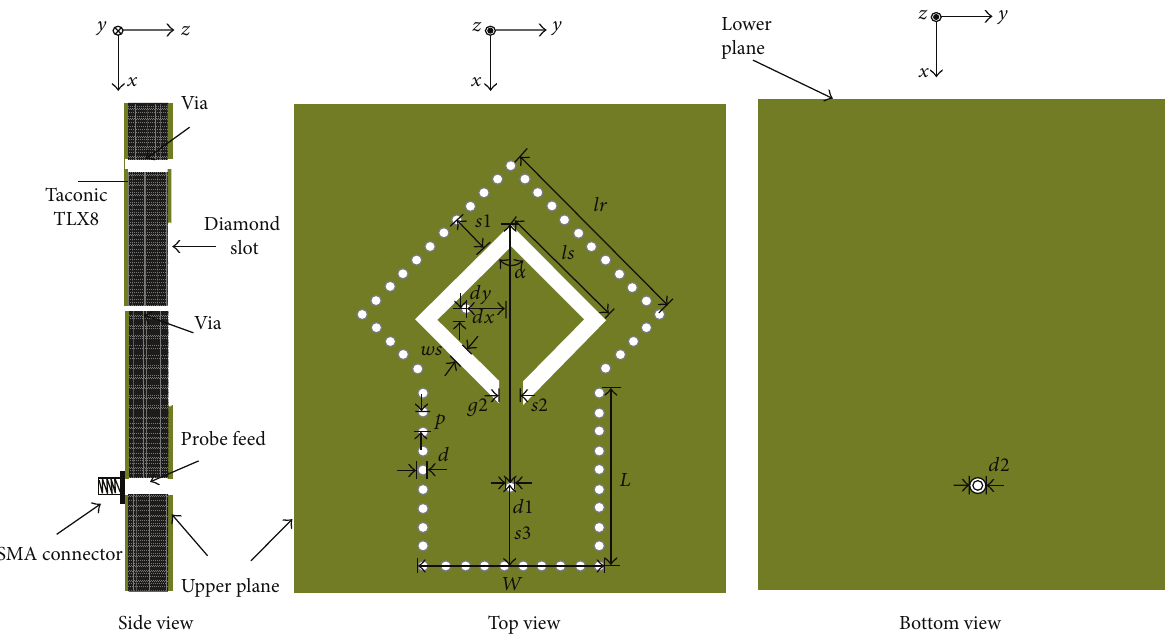
Figure 1: Configuration of the SIW-based element.